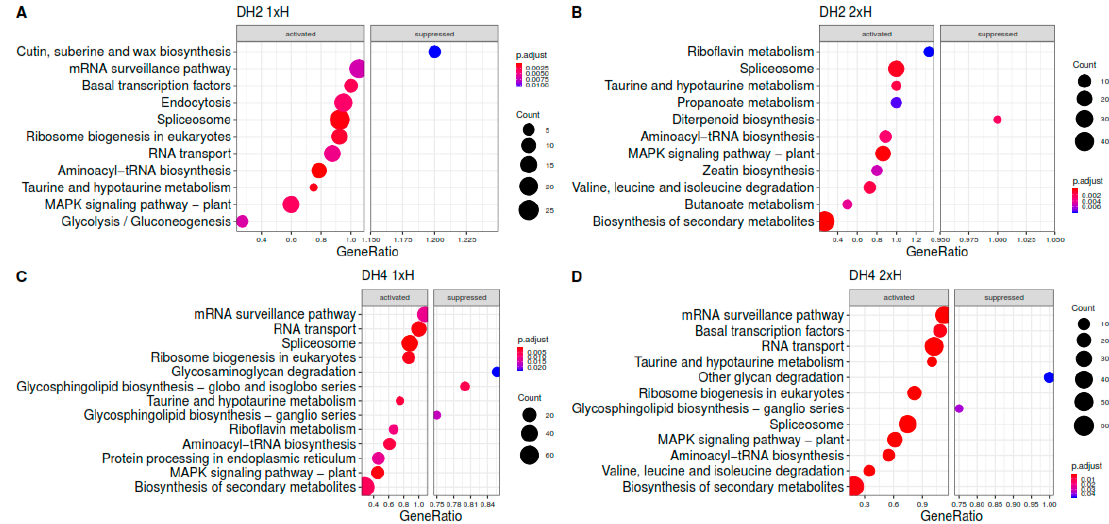
Figure 7. Scatter plot for the KEGG enrichment results obtained for WL-T DH2 ( A , B ) and WL-S ( C , D ) plants treated once (1xH) and twice (2xH) with waterlogging in comparison to untreated plants. The number of core genes (“count”) divided by the total number of genes is the gene ratio. The sizes of the dots represent the number of core genes, and the color indicates the adjusted p -value. Only pathways with p -values < 0.05 were eligible for enriched biological processes.